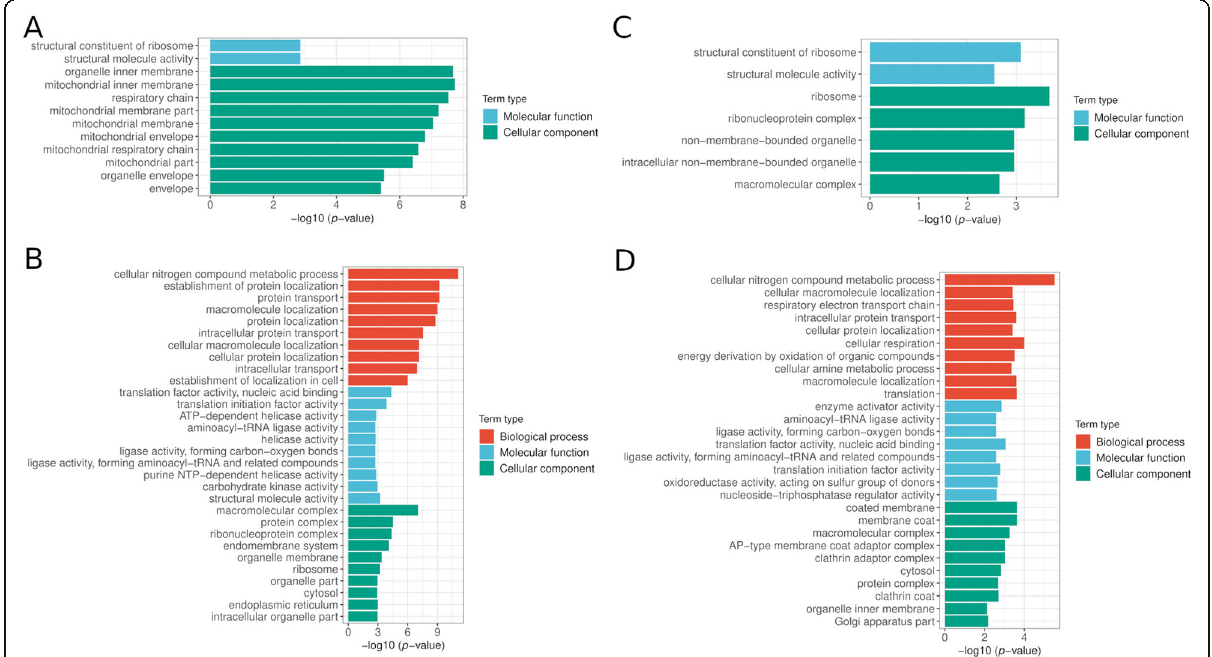
Fig. 6 Functional characteristics of differentially methylated peaks (DMPs) in the context of genic location in cv. 9311 and cv. NIP. ( A ) top 10 over-represented GO term in each category at their 5 ’ -UTR in cv. 9311 ( B ) top 10 over-represented GO term in each category at their 3 ’ -UTR in cv. 9311( C ) top 10 over-represented GO term in each category at their 5 ’ -UTR in cv. NIP( D ) top 10 over-represented GO term in each category at their 3 ’ -UTR in cv.